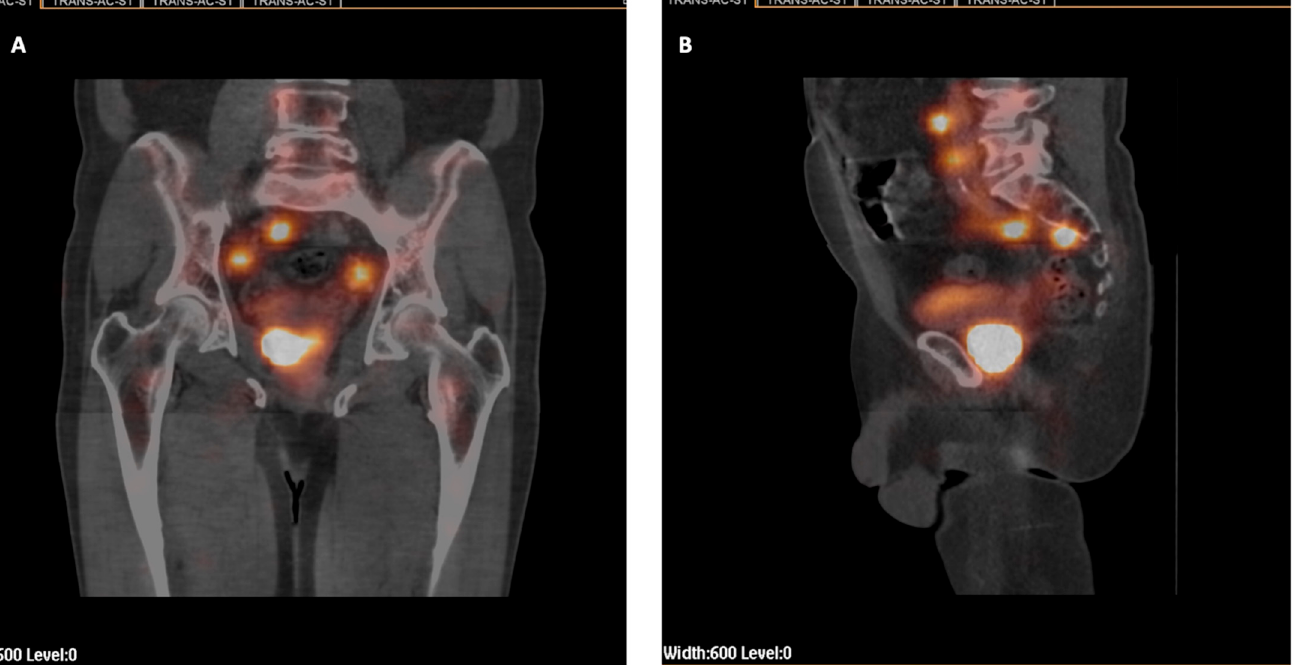
Figure 1. Sentinel lymph node (SLN) procedure in a prostate cancer patient. Fused SPECT-CT im- ages to facilitate anatomic identification of the SLNs: ( A ) Frontal exposition. ( B ) Sagittal exposition.